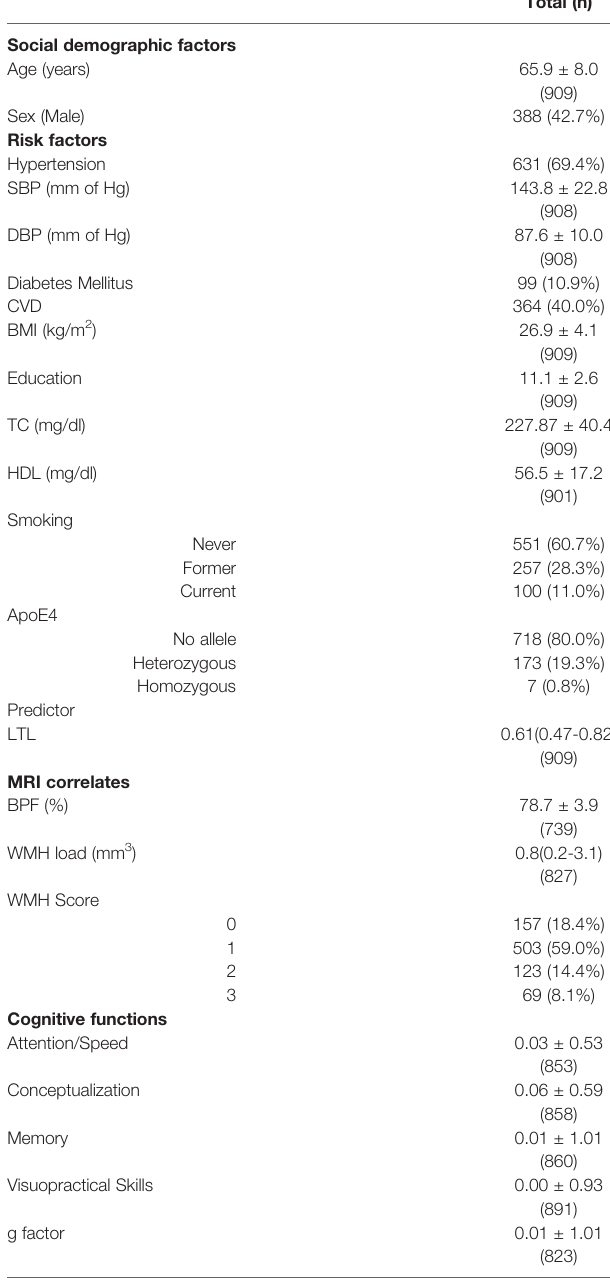
TABLE 1 | Characteristics of the study